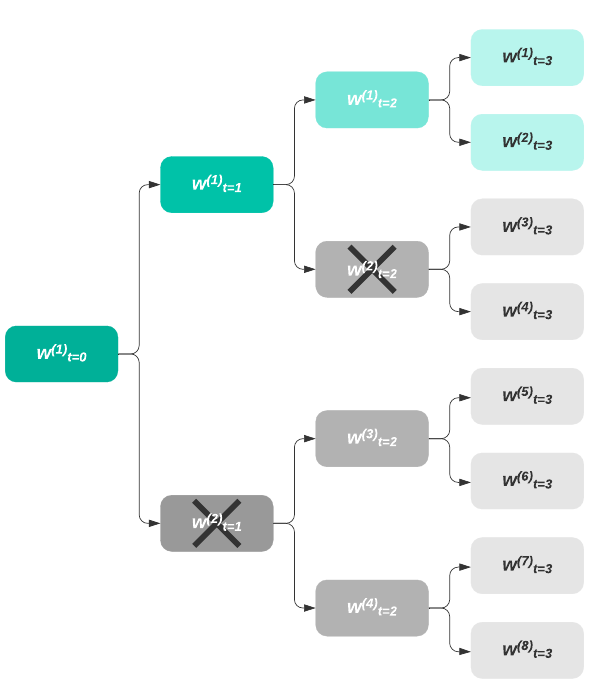
Figure 2. Candidate investment trajectories are efficiently ruled out by the post-selection algorithm. Node i ) i th candidate holdings at time t . Green nodes meet the minimum holding period, while grey ω ( t represents the nodes do not. When the constraint is not met at time t , the node is crossed out and all resulting investment trajectories are